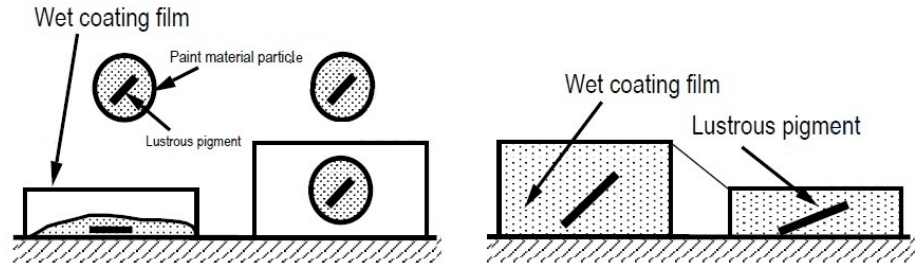
Figure 10. Affective parameters on the arrangement conditions of lustrous pigment.